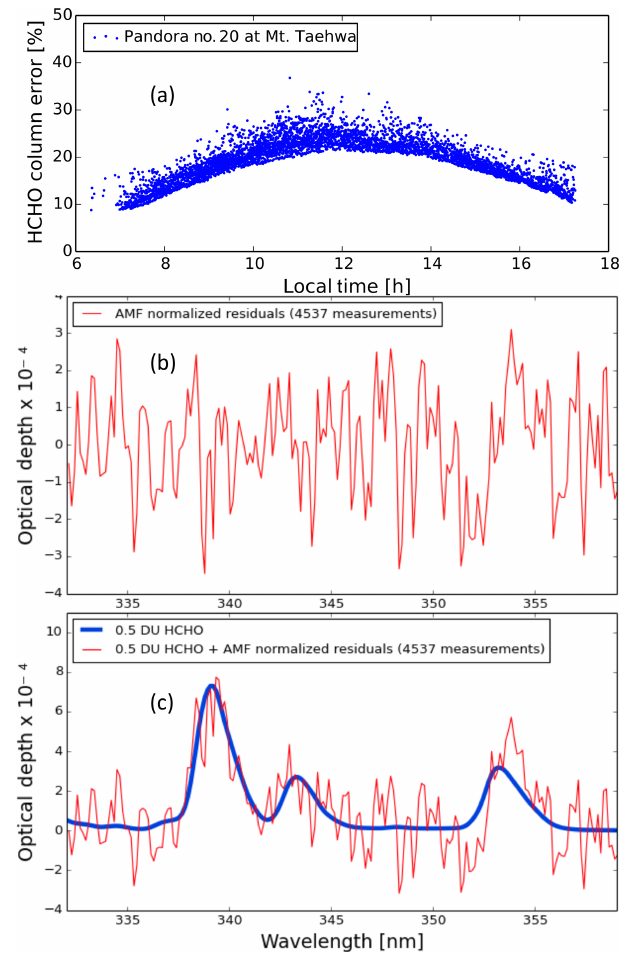
Figure 2. (a) Estimation of total HCHO column errors from Pandora direct-sun measurements during KORUS-AQ (May– June 2016) at Mt. Taehwa; (b) common DOAS fitting optical depth residuals normalized by direct-sun AMF (4537 measurements); (c) optical depth of 0.5DU HCHO (convolved with Pandora instru- ment transfer